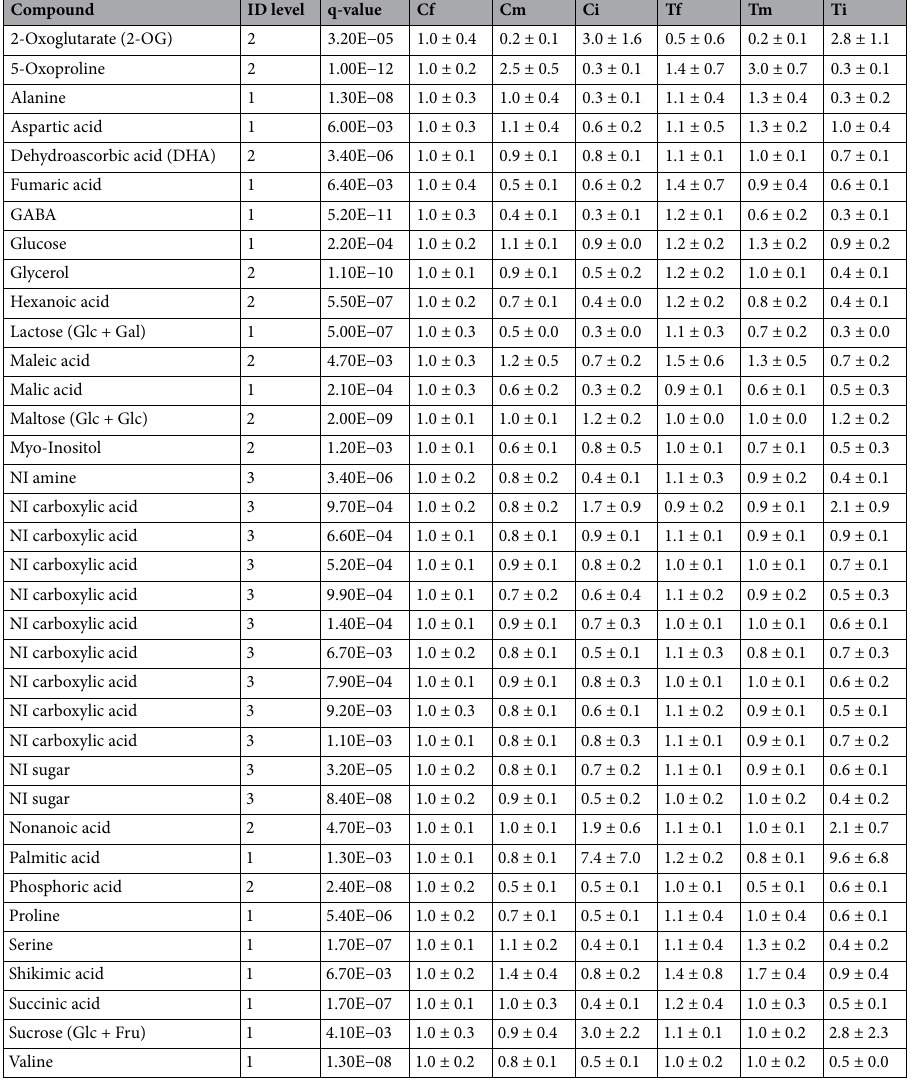
Table 4. Metabolites with significant differences (ANOVA, FDR-adjusted p < 0.05 ) on Experiment 3 (greenhouse). Relative levels in relation to control samples obtained on the third/final sampling point (Cf). Control and treated samples obtained at the first/initial (Ci, Ti), second/intermediary (Cm, Tm) and third/final (Cf, Tf) sampling points. ID level (1: confirmed with analytical standards; 2: confirmed with retention index and mass spectra from NIST and GMD; 3: non-identified metabolite—functional group prediction according to their mass